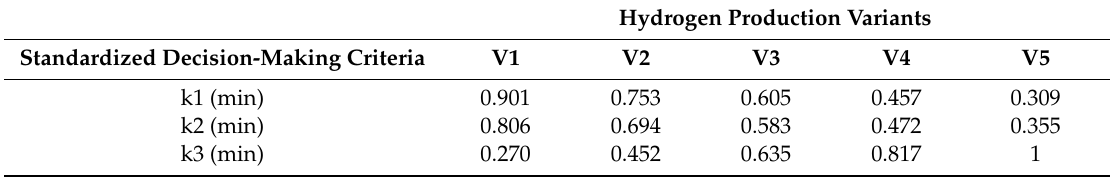
Table 2. Standardized values of decision-making criteria—own